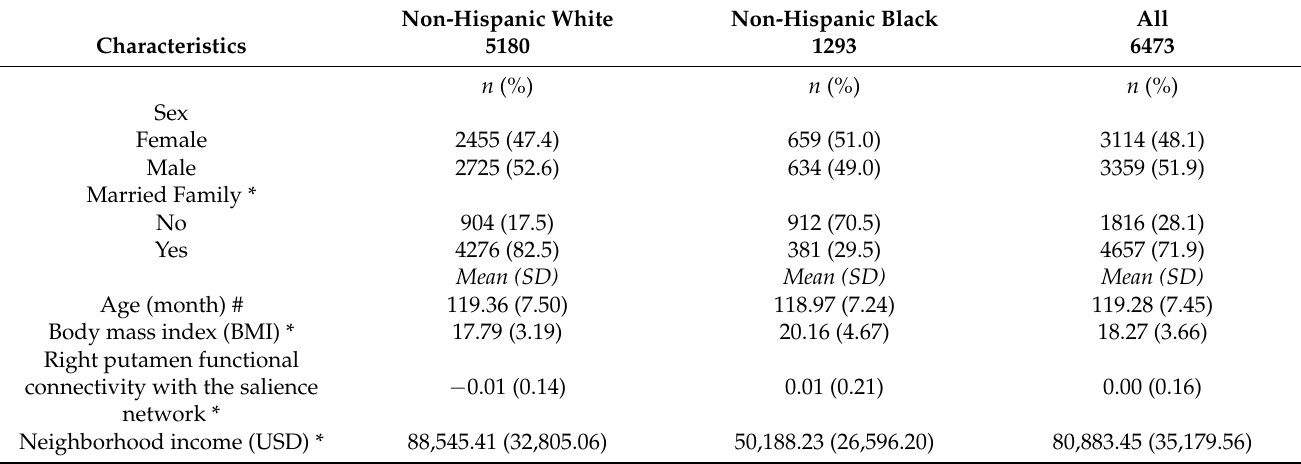
Table 1. Descriptive statistics in the sample overall and by race.